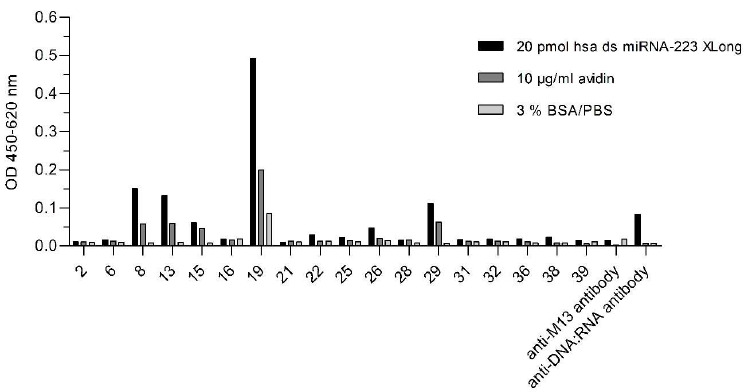
Figure 4. Monoclonal phage ELISA for the detection of hsa ds miRNA-223 XLong-specific VHH binders. Eighteen clones were selected from the last round of panning to produce the monoclonal phage particles. Their binding preference toward the hsa ds miRNA-223 XLong (20 pmol), a carrier protein (10 µg/mL), and blocking solution (3% BSA/PBS) was investigated. Bound monoclonal phage particles were detected by the secondary antibody anti-M13 HRP (1:7000). The binding of anti-M13 HRP to the antigens only was also performed. Additionally, a coating control for the immobilized hsa ds miRNA-223 XLong conjugated on avidin was carried out using the commercially available anti-DNA:RNA antibody (clone S9.6) which was detected with goat anti-mouse IgG HRP (Fcγ). 2.2. Expression and Purification of Recombinant VHH_19 From the positive clone 19, the plasmid pCOMB3x-VHH_19 was isolated and se- quenced. The amino acid sequence of VHH_19 (Figure 5) was numbered according to the Kabat numbering system. The four typical aa substitutions were detected at positions 37, 44, 45, and 47. Moreover, the sequence possesses two conserved Cys residues at positions 22 and 9, which are typical for VHHs. The sequences for His-tag (for purification) and HA-tag (for detection) are present after framework 4. VHH_19 clone was expressed in a soluble form in the periplasmic space of E. coli HB2151 and purified via Ni-NTA affinity chromatography. The presence of VHH_19 in the elution fractions was confirmed by Western blot (WB). The protein bands (Figure 6) between 15 and 20 kDa were detected by an anti-HA-tag antibody in the following collected samples: total protein, periplasmic fraction 1 and 2 (before and after the dialysis with native binding buffer (NBB) containing 10 mM imidazole) and in the elution fractions 1 and 2 indicating the expressed VHH_19. No protein bands could be detected in the flow-through or in the wash fraction. The VHH_19 concentration of 2284 µg/mL was determined via the bicinchoninic acid (BCA) assay.